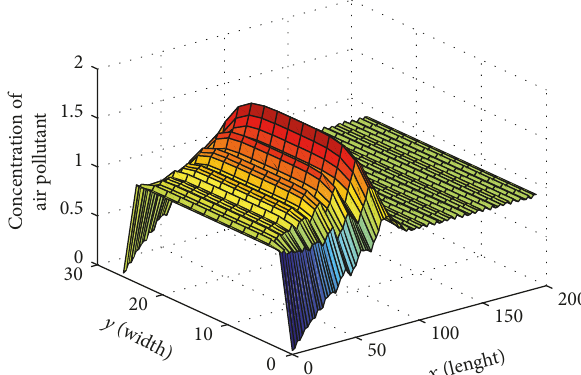
Figure 19: Surface plot of concentration of air pollutant levels for 𝑅